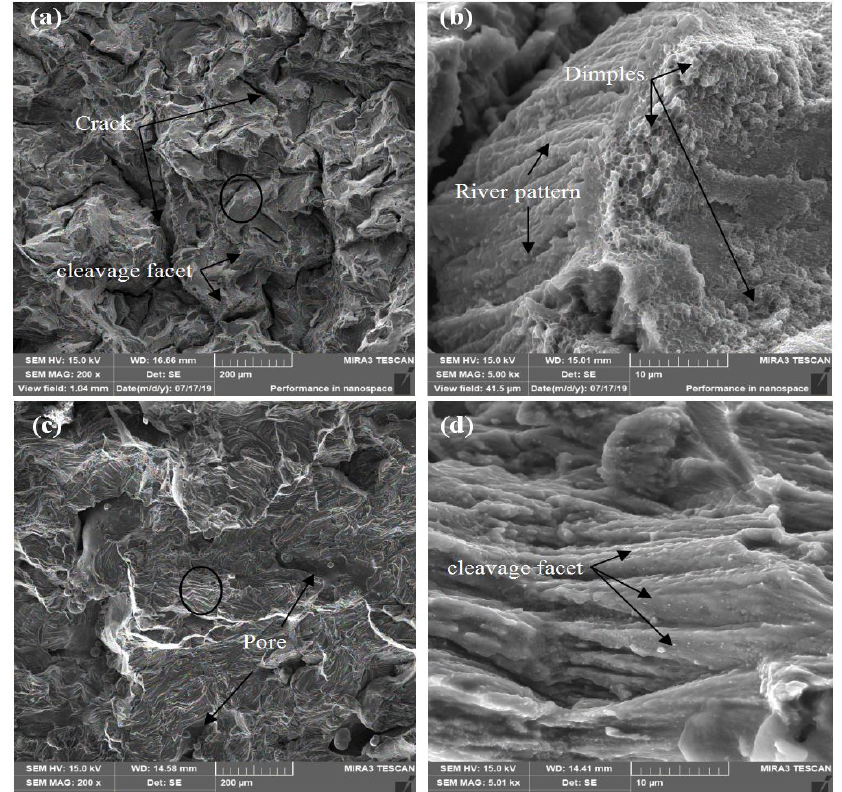
Figure 12. SEM images of the fracture surfaces of SLM-produced 2124. ( a ) Vertically built sample and ( c ) horizontally built sample at room temperature. ( b , d ) are enlarged images of the regions in the black ( c ) horizontally built sample at room temperature. ( b ) and ( d ) are enlarged images of the regions in the black circles in ( a ) and ( c ), respectively. circles in ( a , c ),